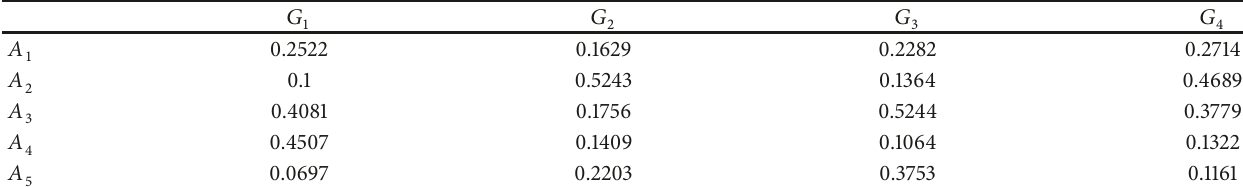
Table 9: Order-inducing vectors obtained by our TOPSIS-based method for problem in [38].